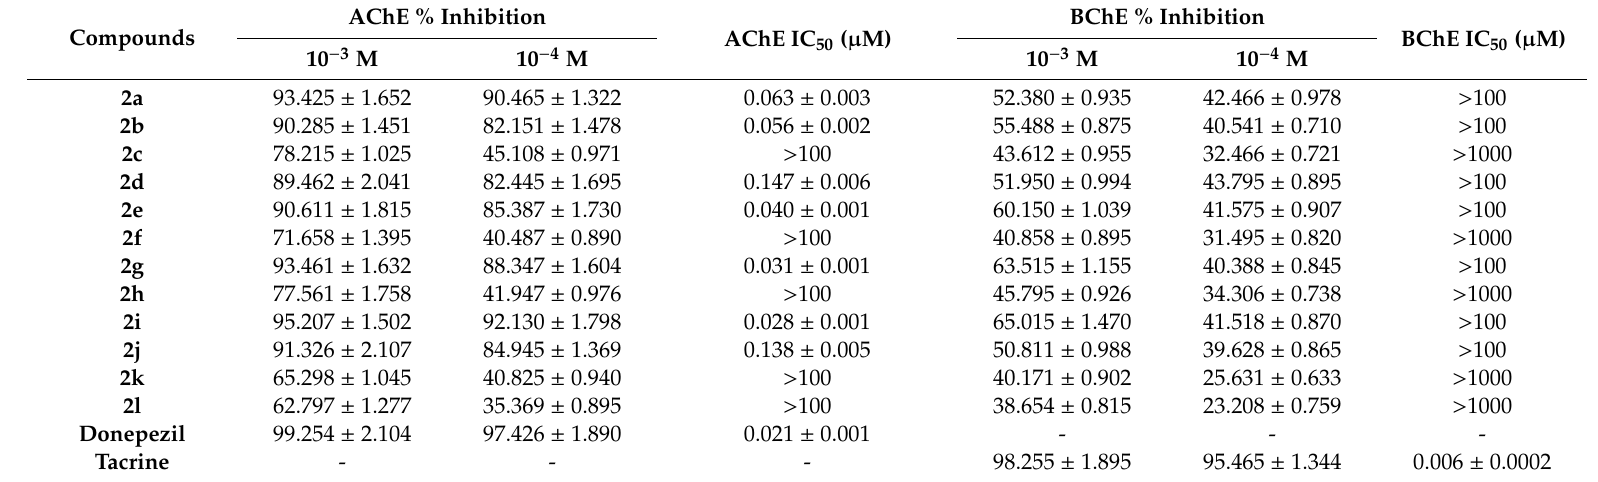
Table 1. % Inhibition and IC 50 values of the synthesized compounds, donepezil and tacrine against AChE and BChE enzymes.